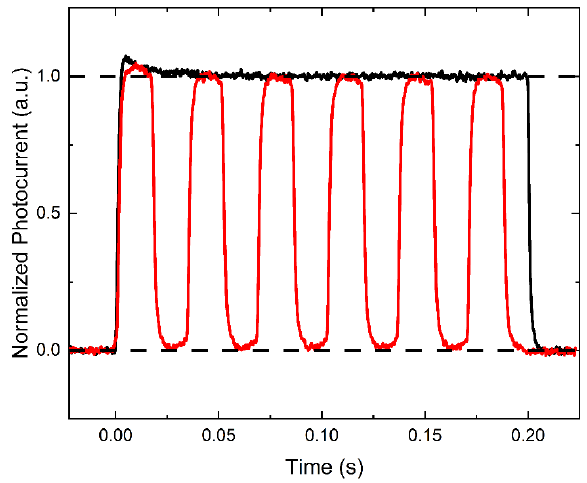
Figure 3. The X-ray response of the PI/a-PbO detector, biased at 20 V/ µ m, to a continuous (black) and modulated (red) beam of X-rays. Modulated beam has a frame rate of 30 frames per second, matching that used in fluoroscopy. The photocurrent is normalized to the steady-state magnitude of the continuous response.